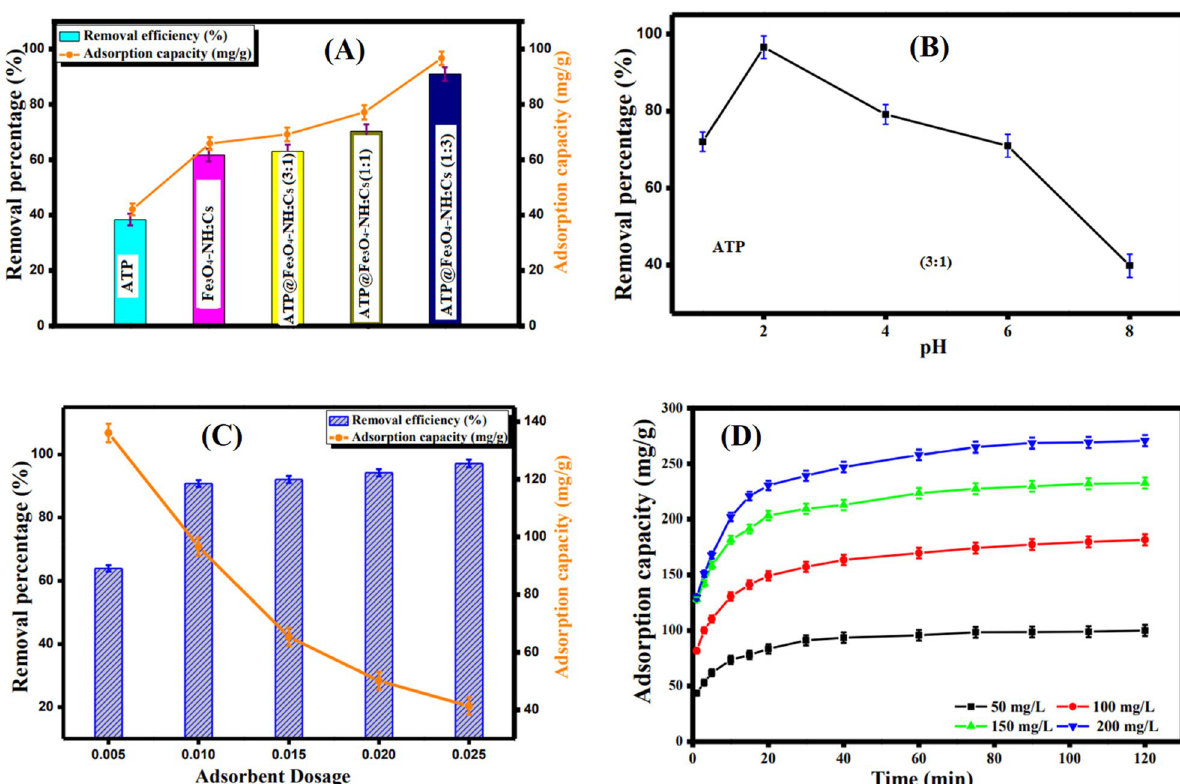
Figure 6. ( A ) Adsorption profiles of Cr(VI) onto ATP, Fe 3 O 4 -NH 2 Cs, ATP@Fe 3 O 4 -NH 2 Cs (3:1), ATP@Fe 3 O 4 - NH 2 Cs (1:1) and ATP@Fe 3 O 4 -NH 2 Cs (1:3), ( B ) Effect of pH, ( C ) Effect of dosage and ( D ) Effect of initial Cr(VI) concentration on the adsorption capacity. Sample composition Sample code ATP : Fe 3 O 4 -NH 2